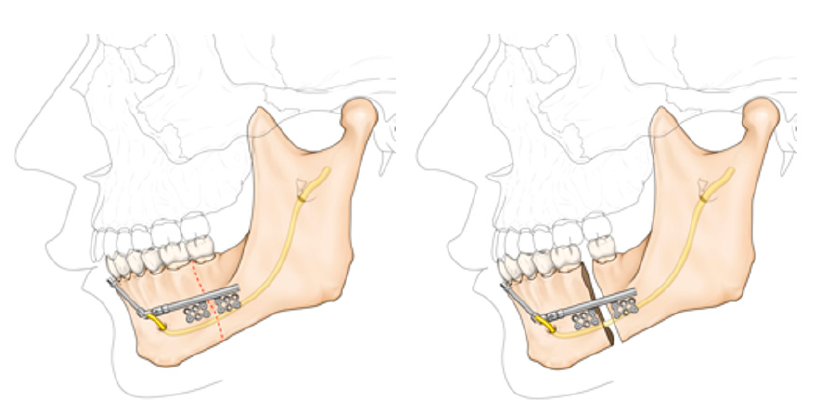
Figure 2. Distractor placement in the molar region of the lower jaw. Osteotomy between first and second molar. © Copyright Kei Koyama 2020. All rights